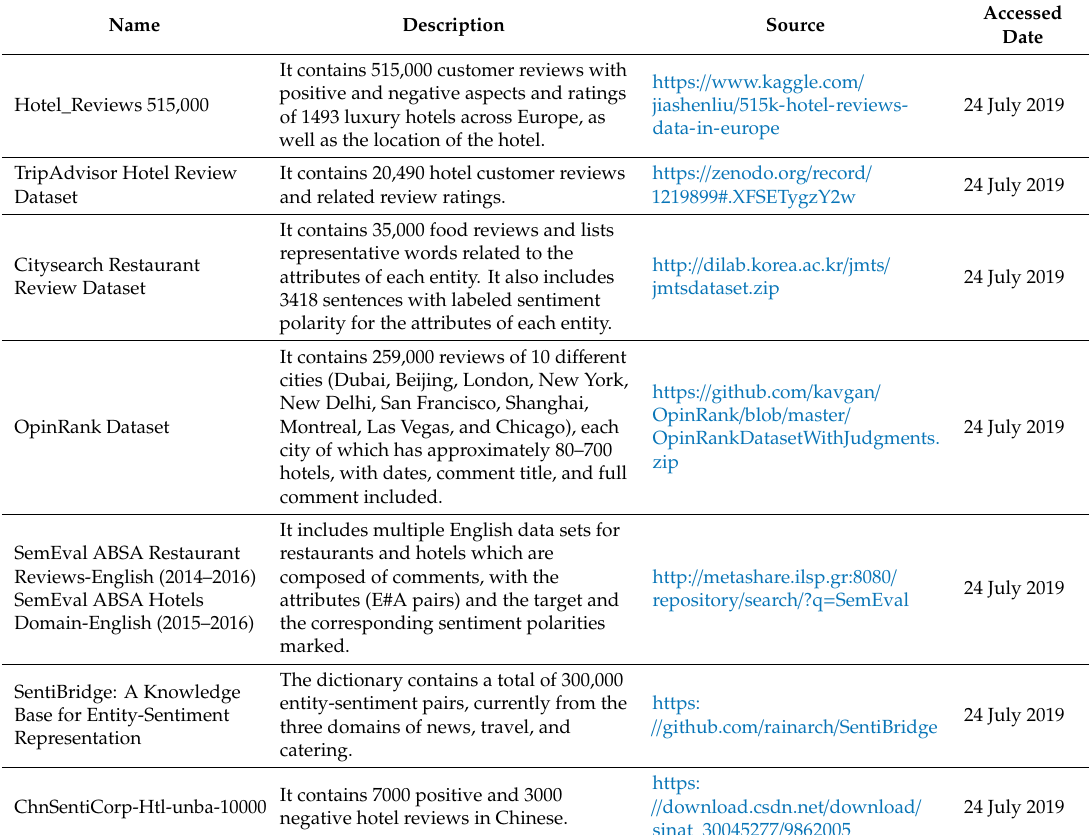
Table 7. Publicly available tourism data